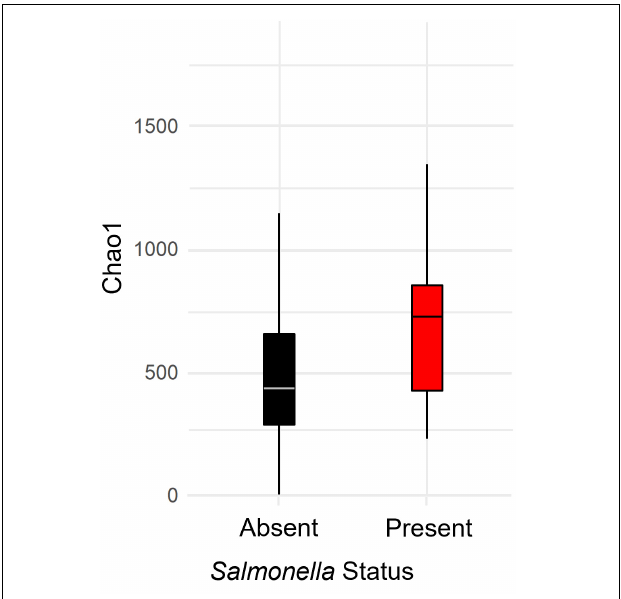
FIGURE 3 | Bacterial alpha diversity, as estimated by the Chao1 statistic, by Salmonella spp. status (absent, present) in barn swallow ( Hirundo rustica ) fecal samples collected in Israel. Salmonella -absent samples had significantly lower diversity than -present samples (Mann-Whitney-Wilcoxon test, p = 0.008).